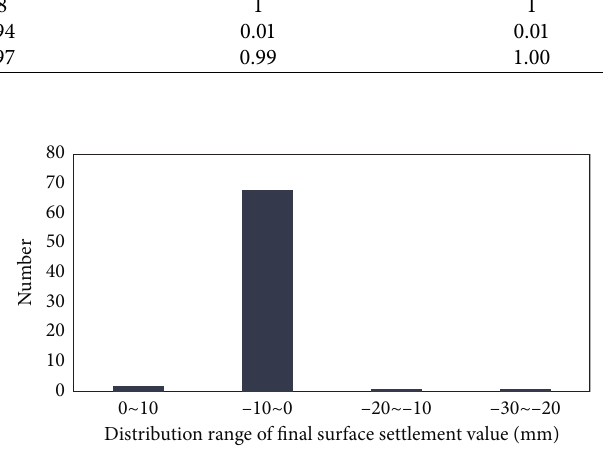
Figure 13: Histogram of final value distribution of surface